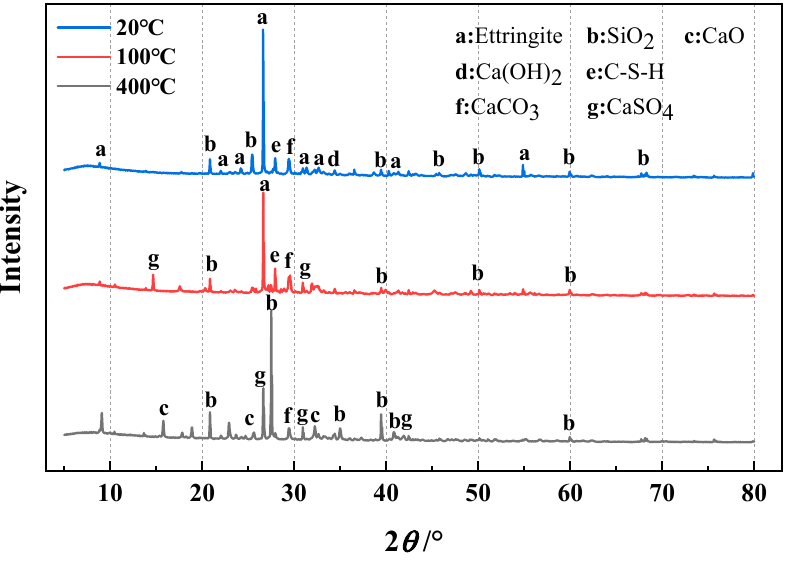
Figure 7. XRD pattern of HSFCM after treatment at different temperatures.